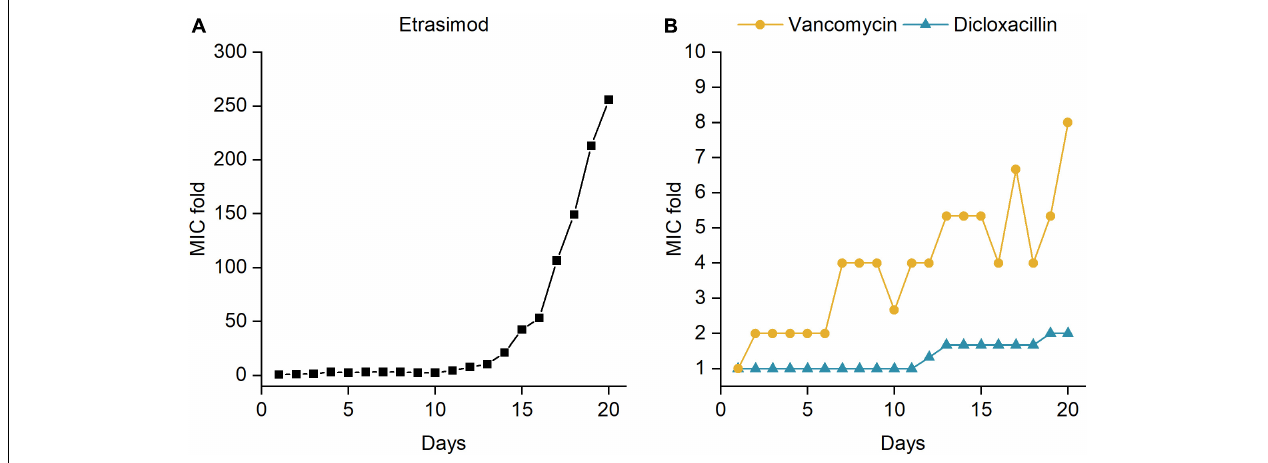
FIGURE 4 | Changes in minimum inhibitory concentration (MIC) over time for Staphylococcus aureus ATCC 25923 exposed to sub-inhibitory concentrations of (A) etrasimod; and (B) vancomycin and dicloxacillin for 20 days. The experiment was repeated with three biological replicates. TABLE 2 | Minimum inhibitory concentrations of the five antibiotic agents against Staphylococcus aureus ATCC 25923, alone and in combination with etrasimod. Antibiotic MIC antibiotic µ M ( µ g/mL) MIC etrasimod µ M ( µ g/mL) FICI Interpretation Alone Combination Alone Combination